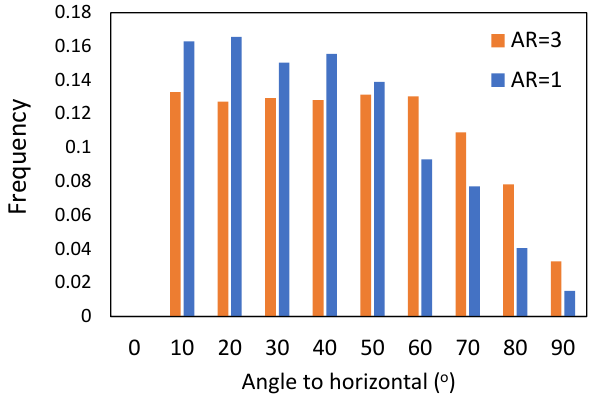
Figure 4. Histogram of vertical orientation of AR = 1 (25%) and AR = 3 (75%) cylinders in initial packing.